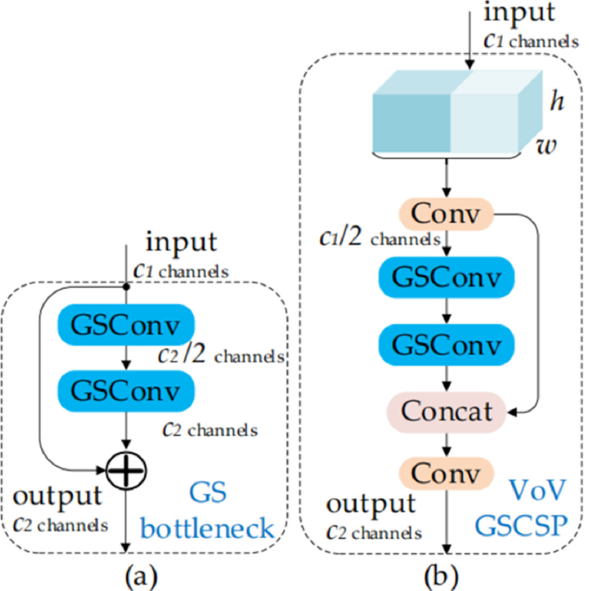
Figure 10. ( a ) Structure of the Gsbottleneck module; ( b ) Structure of the VoV-GSCSP module.